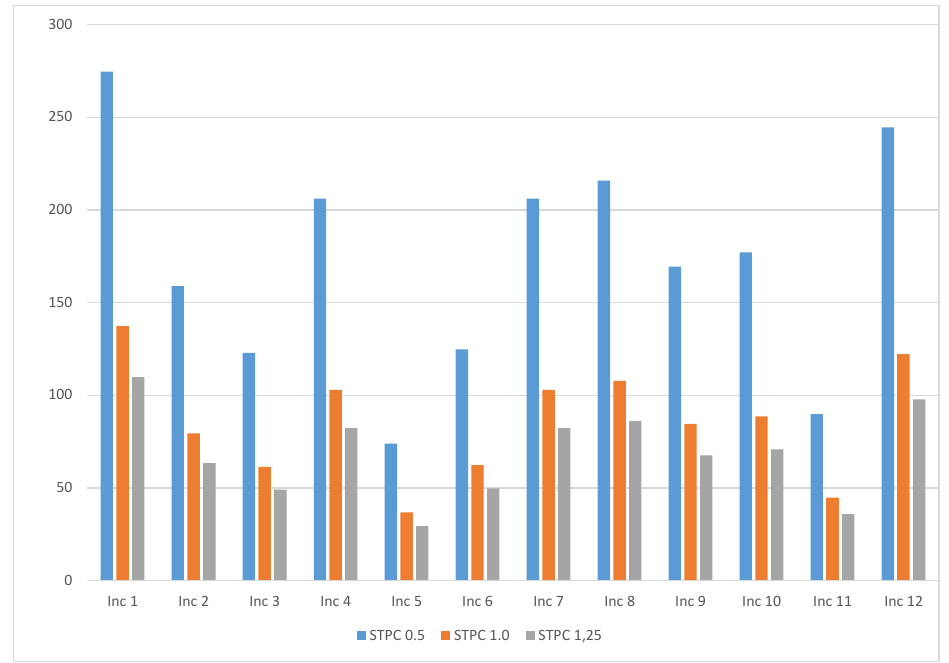
Figure 6. Average values of STPC (short-term peak concentration) ( μ g/m 3 ) for formaldehyde assuming scenarios with different ventilation rates: 0.5 h − 1 , 1.0 h − 1 , and 1.25 h − 1.